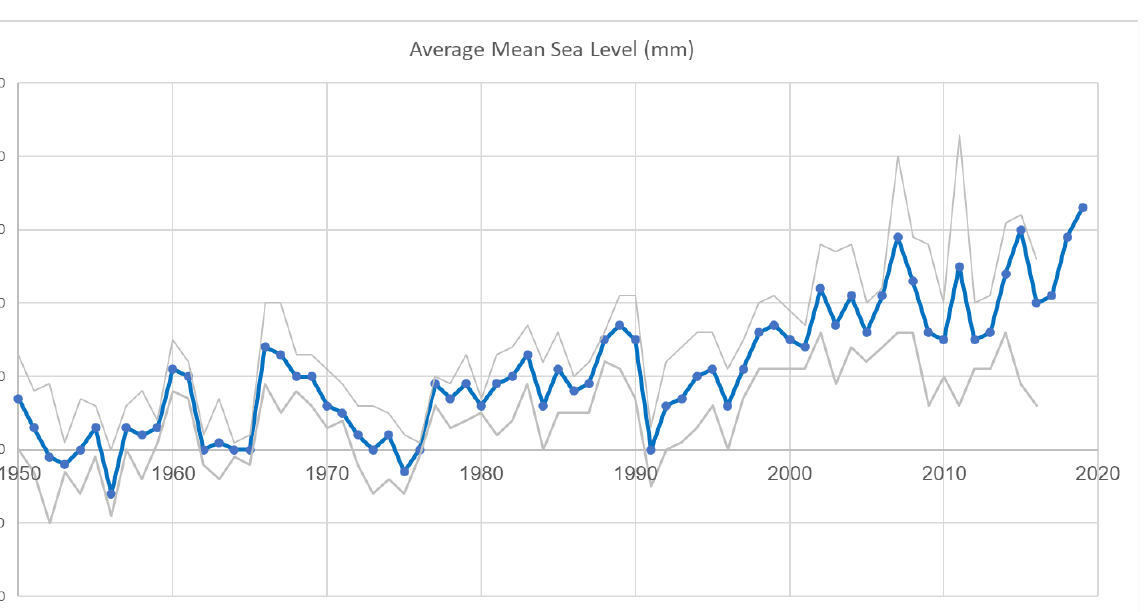
Figure 1. UK sea level indices, after Kendon et al. (2021) [3]. (Mean trend in blue, standard deviations shown in grey).